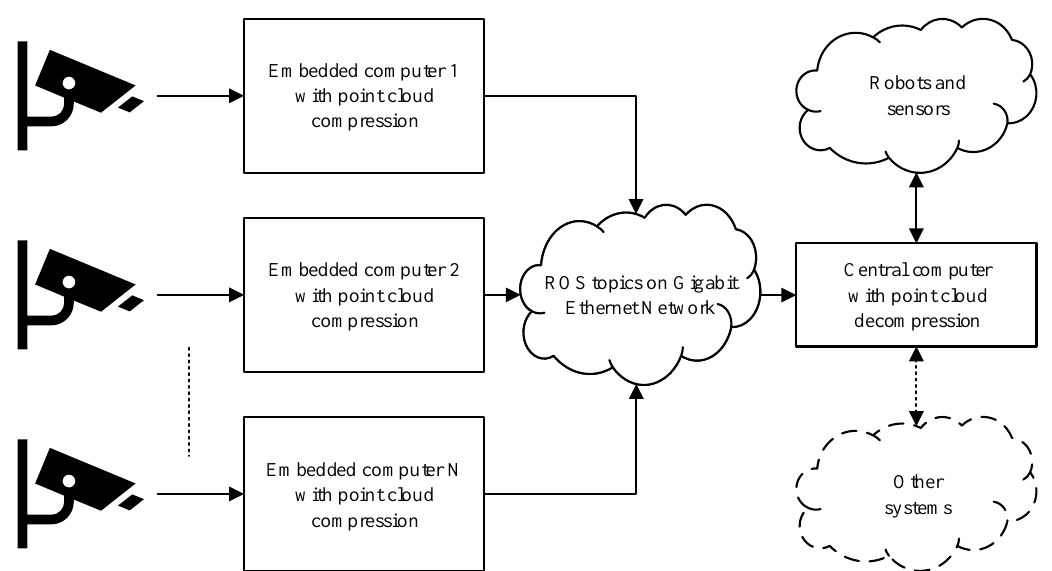
Figure 1. Schematic overview of the considered sensor network. The number of sensors and embedded computers is